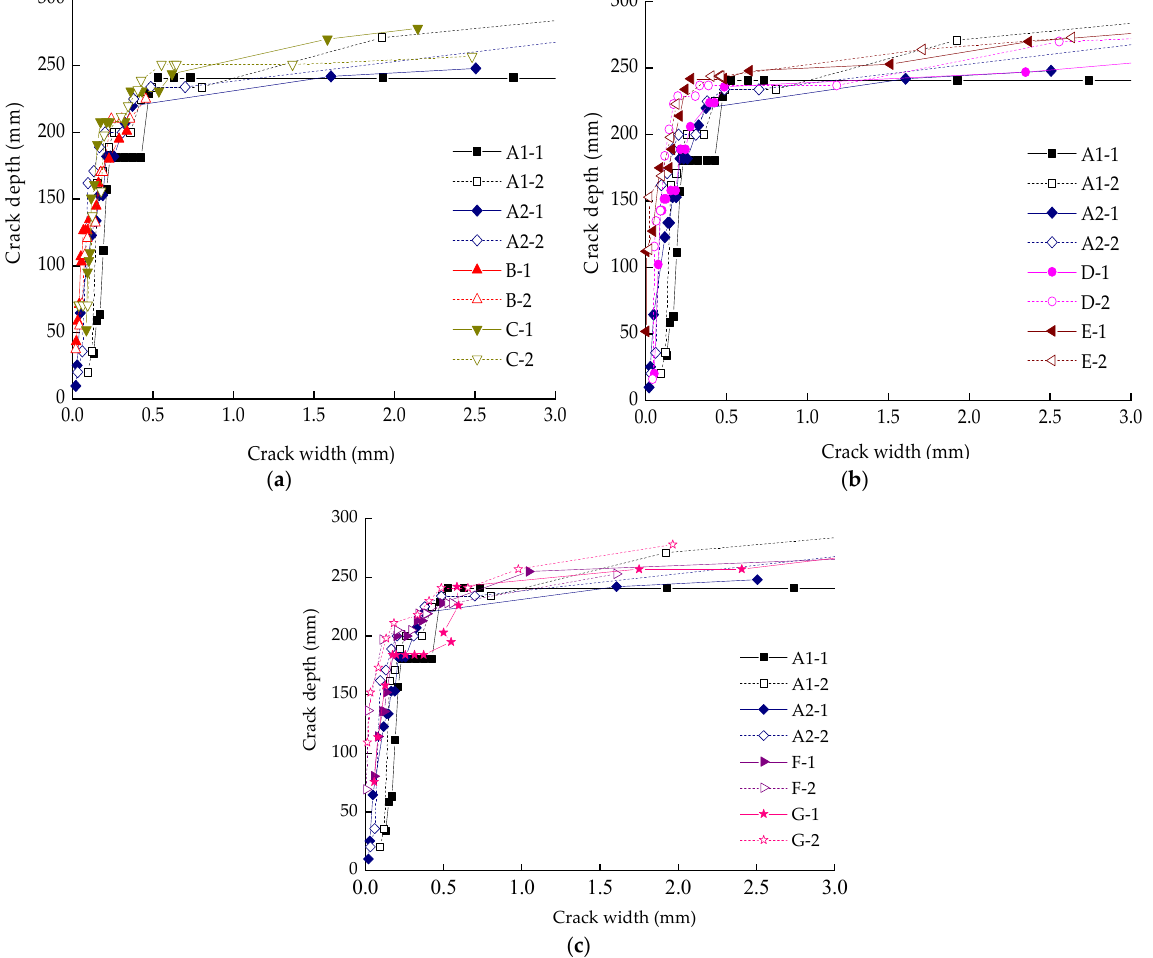
Figure 9. The correlation between crack width and depth with vary ( a ) reinforcement ratio; ( b ) cover thickness and ( c ) concrete strength.